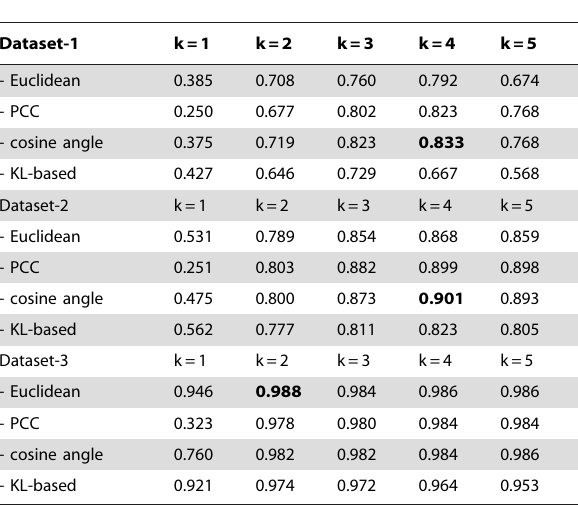
Table 2. Performance of the KFV algorithm on the three datasets measured as the accuracy from the ‘‘best hit’’ test.